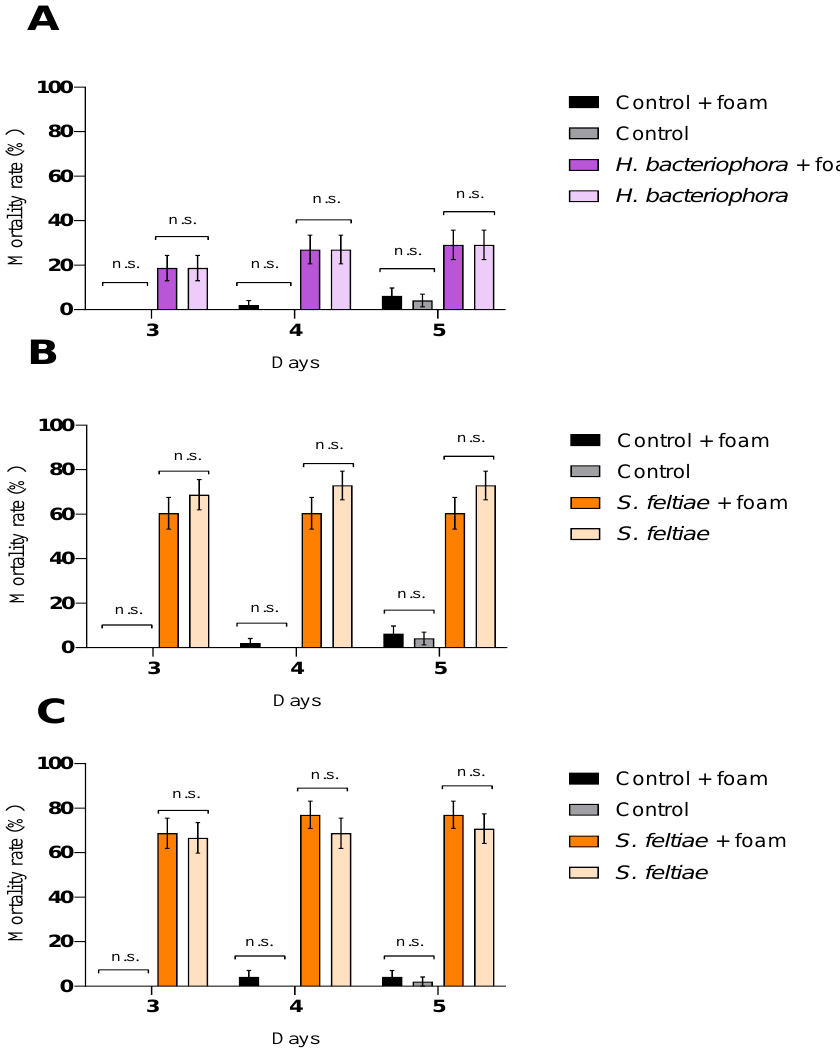
Figure 1. Entomopathogenic nematode pathogenicity against Galleria mellonella larvae after exposure to the foam produced for Philaenus spumarius . Cumulative larval mortality (three to five days) at ( A ) 24 h exposure for Heterorhabditis bacteriophora , ( B ) 24 h exposure for Steinernema feltiae, and ( C ) 72 h exposure for S. feltiae. No significant differences (n.s.) ( p < 0.05) in general linear model testing within pair-treatment comparisons of exposure and no exposure to foam were found. Values are least-square means ± SE.